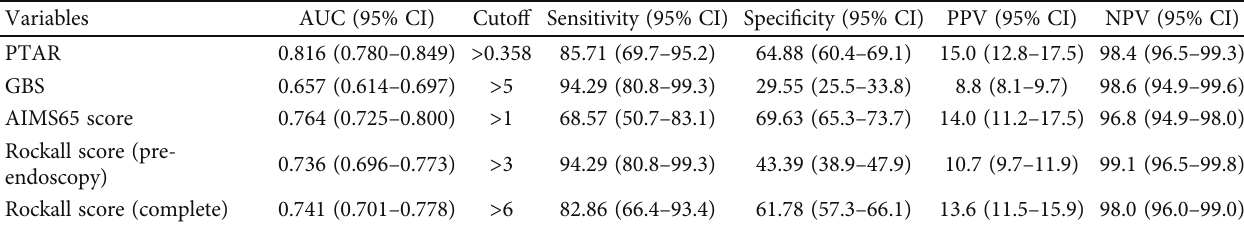
Table 4: Predictive variables of